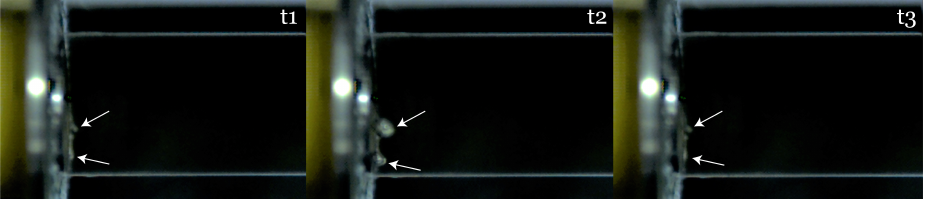
Figure 9. Proximal plunger bubble dynamics for Re = 1000, at ( t1 ) bubble growth, ( t2 ) peak size, and ( t3 ) collapse. The bubbles are highlighted with white arrows.